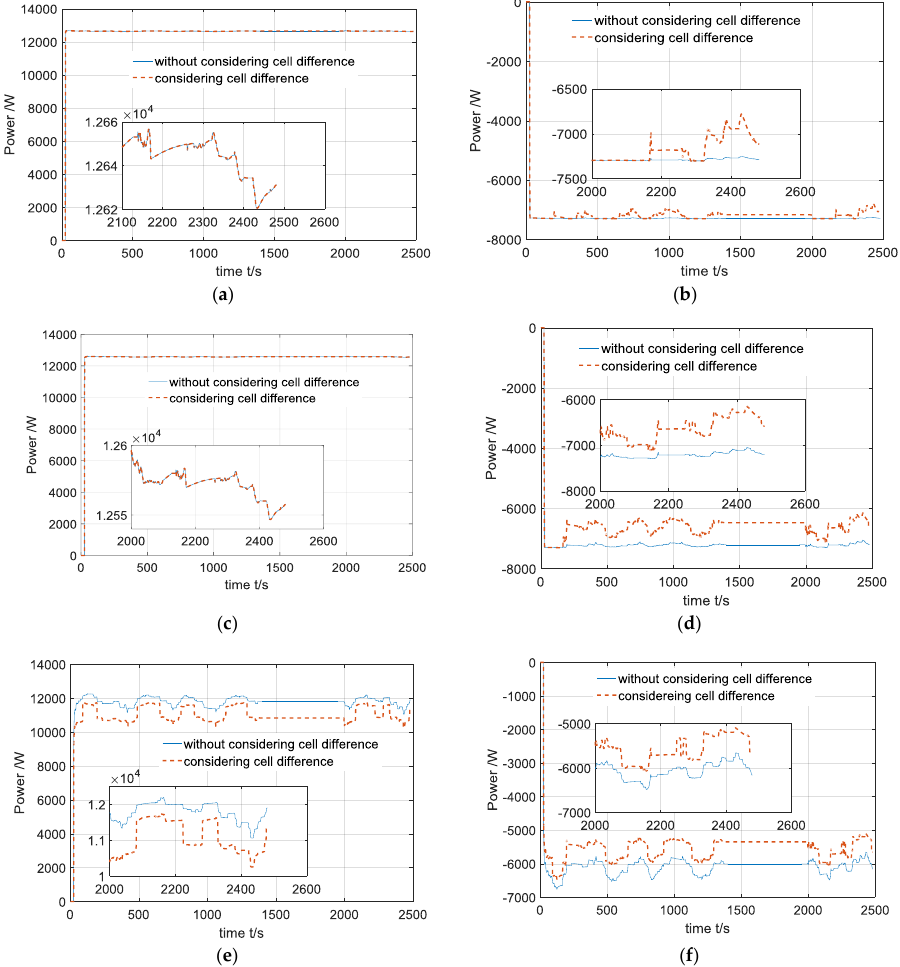
Figure 13. Power estimation results under the FTP75 cycle test: ( a ) 1 s discharge power estimation result; ( b ) 1 s charge power estimation result; ( c ) 10 s discharge power estimation result; ( d ) 10 s